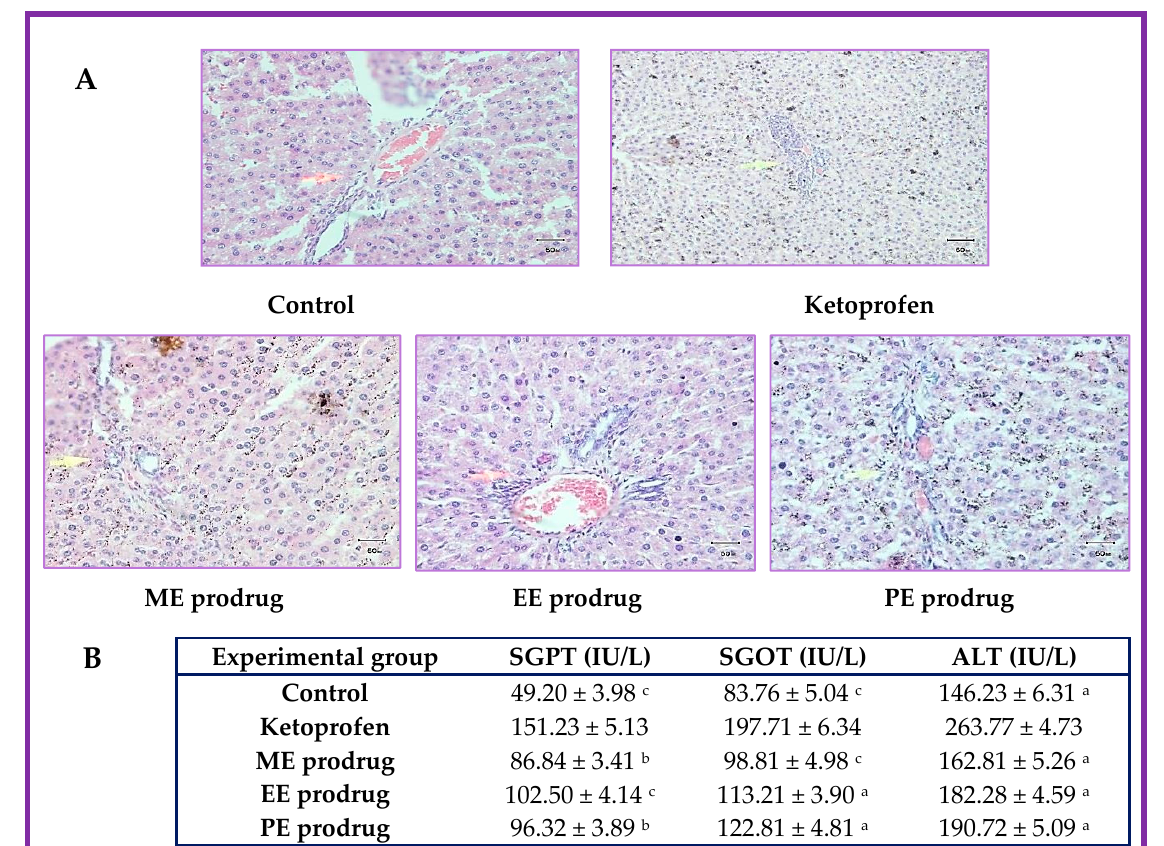
Figure 7. Hepatotoxicity of ester prodrugs of ketoprofen. ( A ): Histopathology of liver of experimental groups, ( B ): Liver function enzymes of experimental animals. Data was expressed as mean ± SEM, where n = 5. Values of a: p < 0.001, b: p < 0.01 and c: p < 0.05 vs. ketoprofen treated group were considered significant.